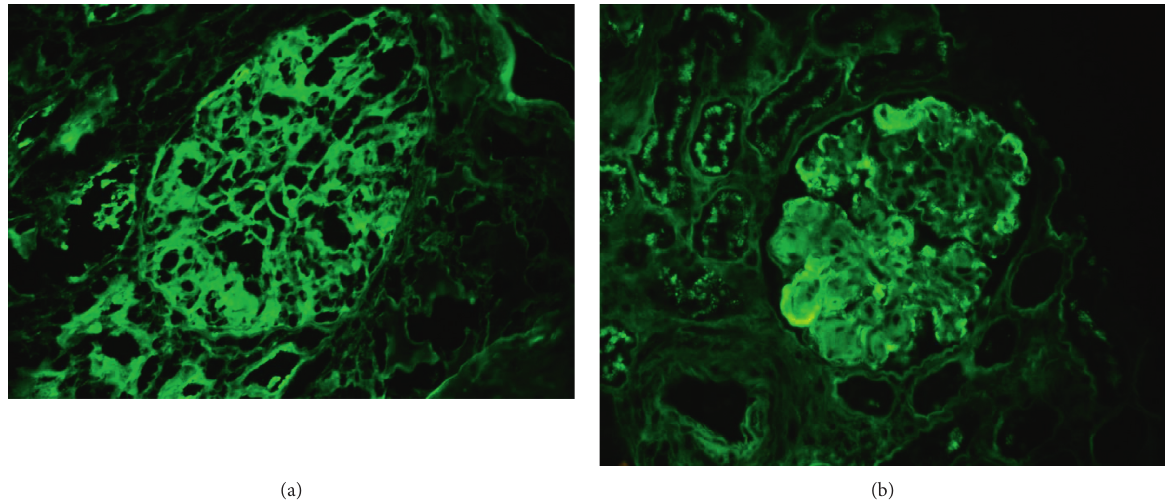
Figure 2: Direct immunofluorescence on fresh frozen tissue was performed; no evidence of deposits was observed (a) (IgG, 400x). Direct immunofluorescence on paraffin-embedded, pronase-digested sections was carried out; in contrast to routine IF, there were deposits of IgG and kappa light chains in the capillary walls (b) (kappa,